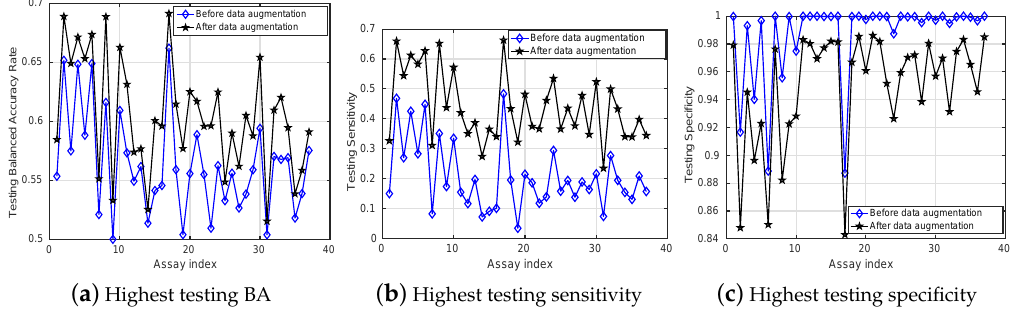
Figure 4. Comparison between the highest testing results ( y -axis) versus different assay index ( x -axis) on both unbalanced and balanced datasets. The interpretation of the results in this figure should be viewed as "heuristic" since a careful interpretation would require a detailed analysis of the statistical confidence intervals for each